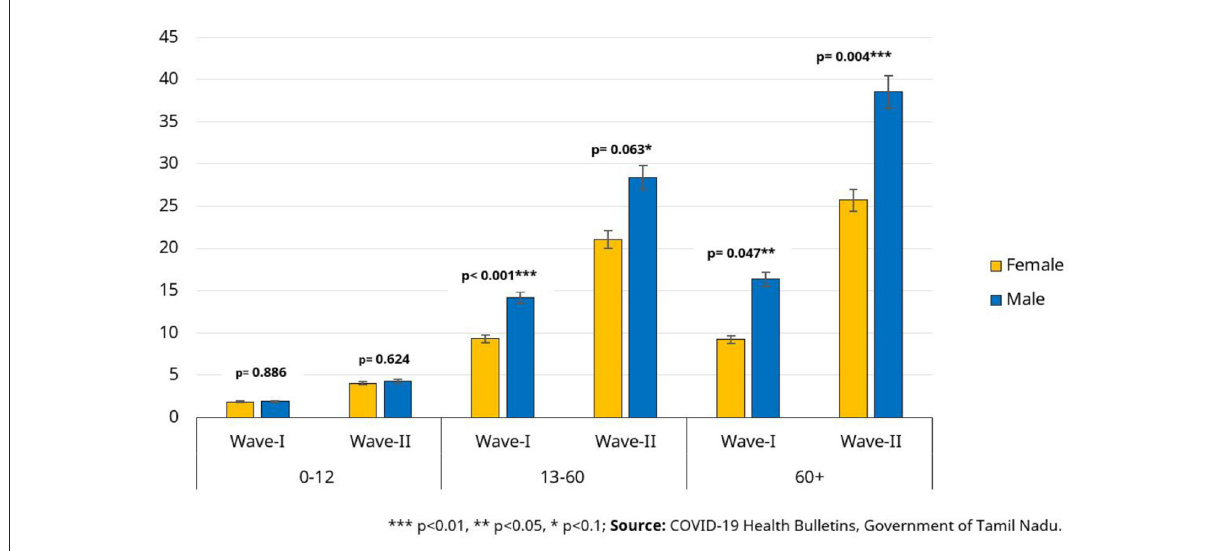
FIGURE1 Confirmed cases per 1000 individuals (naive attack rate) for Tamil